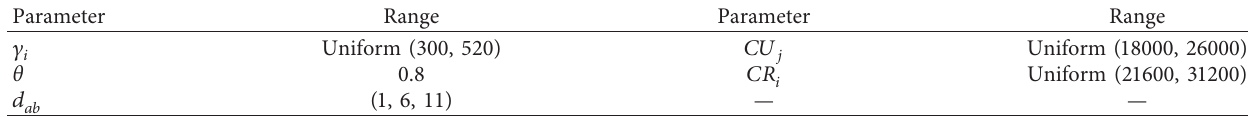
Table 1: Partial parameter range table.